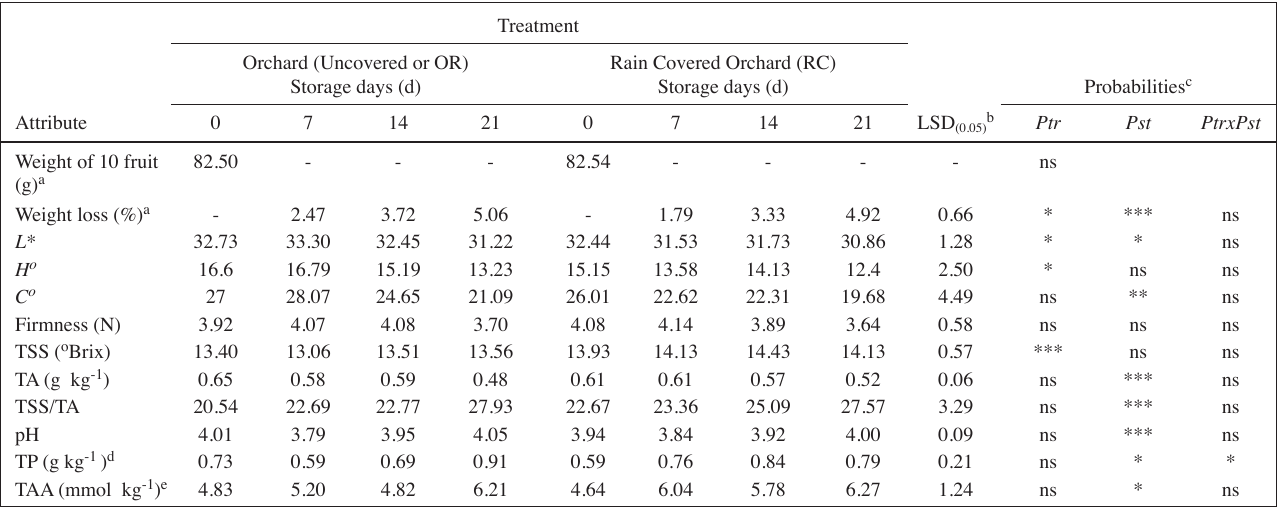
Tab. 4: Effects of rain cover on quality attributes in ‘Adriana’ cherries at harvest and after storage, in 2009.